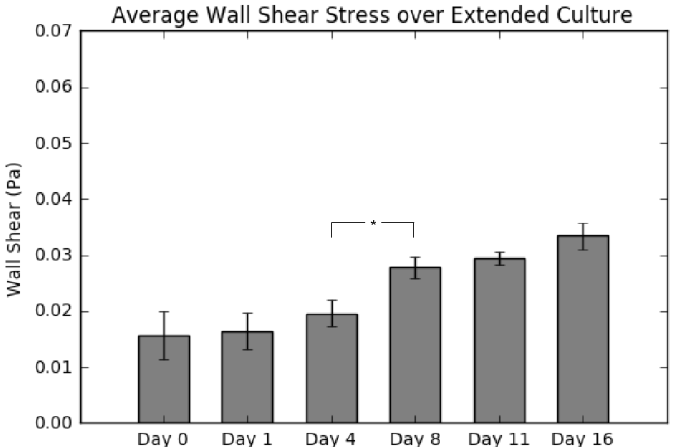
Figure 7. Summary of average shear stress per layer for a 0.5 mL/min flow rate. Values are given as the mean ± the standard error of the mean ( n = 3). Significance calculated via analysis of variance (ANOVA) with the Tukey honest significant difference (HSD) post-hoc